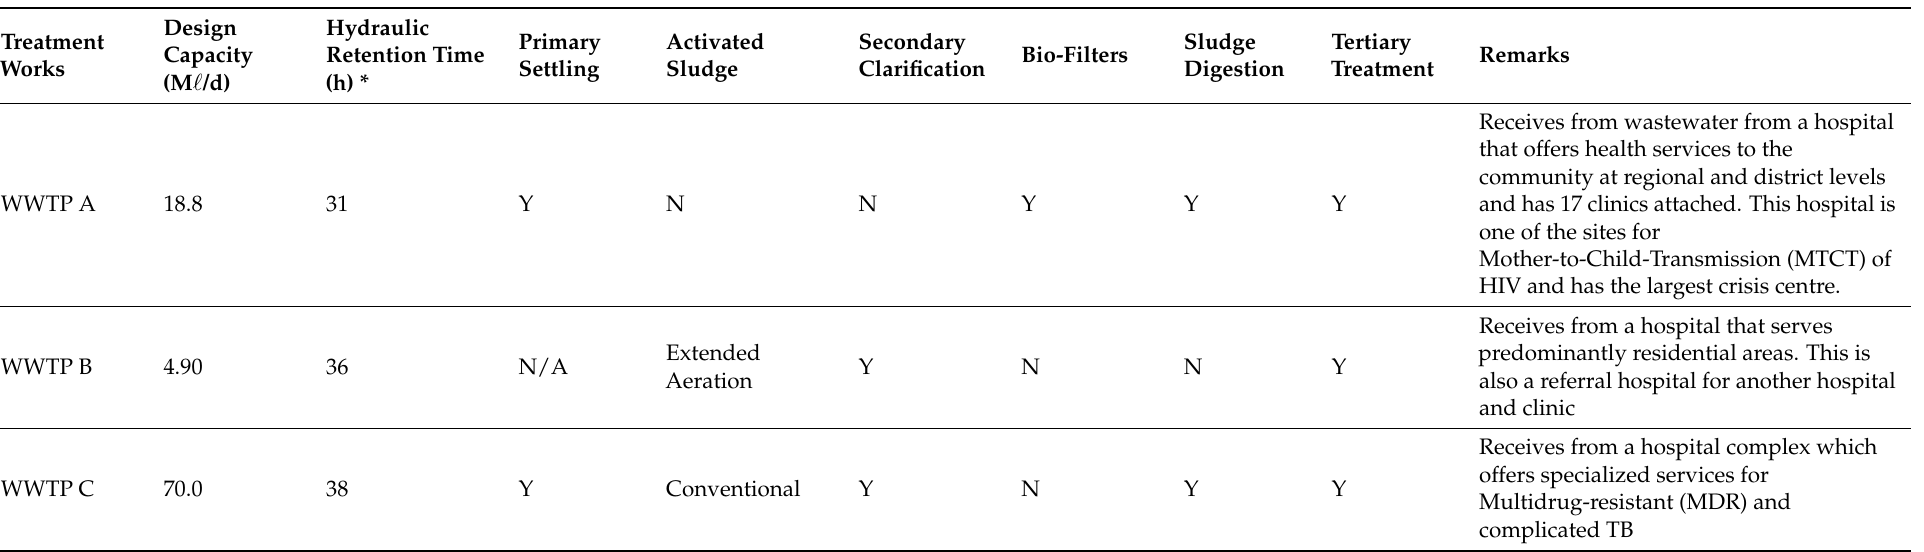
Table 1. Details of the wastewater treatment plants used for this